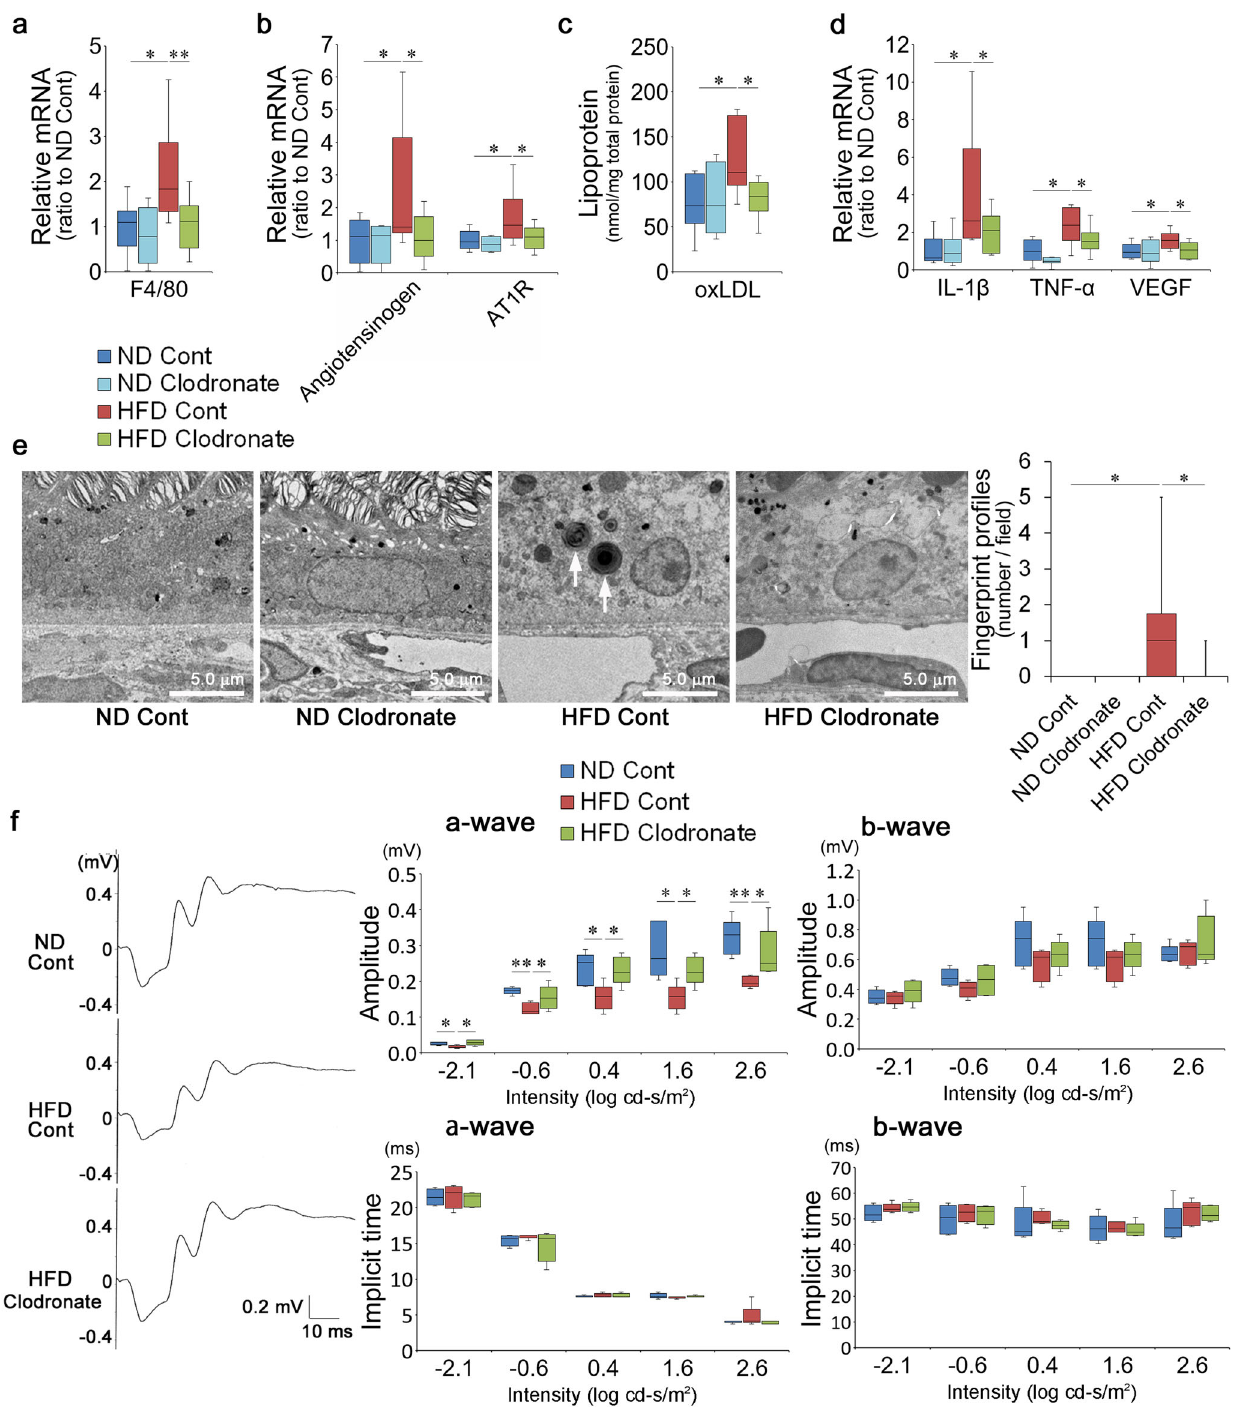
Fig. 4 Macrophages were responsible for visual impairment and RPE disorder. a Macrophage elimination in HFD mice by clodronate liposomes was con fi rmed by decreases in F4/80 mRNA in the RPE – choroid. The control treatment was done using control liposomes. b – d Macrophage elimination repressed angiotensinogen and AT1R ( b ) and reduced ox-LDL ( c ) and the in fl ammatory cytokines IL-1 β , TNF α , and VEGF ( d ) in the RPE – choroid. e EM showed that abnormal fi ngerprint pro fi les (arrows), representing lysosomal de fi ciency, in the RPE were rare in the absence of macrophages. Control liposomes did not cause any differences in ND mice. f Representative ERG waveforms from individual mice, the amplitudes, and implicit times of a- and b-waves at 1 month. Visual function was preserved in HFD mice when macrophages were eliminated. HFD high-fat diet, RPE retinal pigment epithelium, AT1R angiotensin II type 1 receptor, EM electron microscopy, ERG electroretinogram. Respective numbers for ND mice treated with control, ND mice treated with clodronate, HFD mice treated with control, and HFD mice treated with clodronate were a , c 10, 8, 10, 10; b , d 6, 8, 10, 10; e n = 10 for each group; f n = 5 for each group. The samples were all biologically independent. Data were expressed as means ± standard deviation; * P < 0.05, ** P < 0.01. Scale bar, 5.0 μ